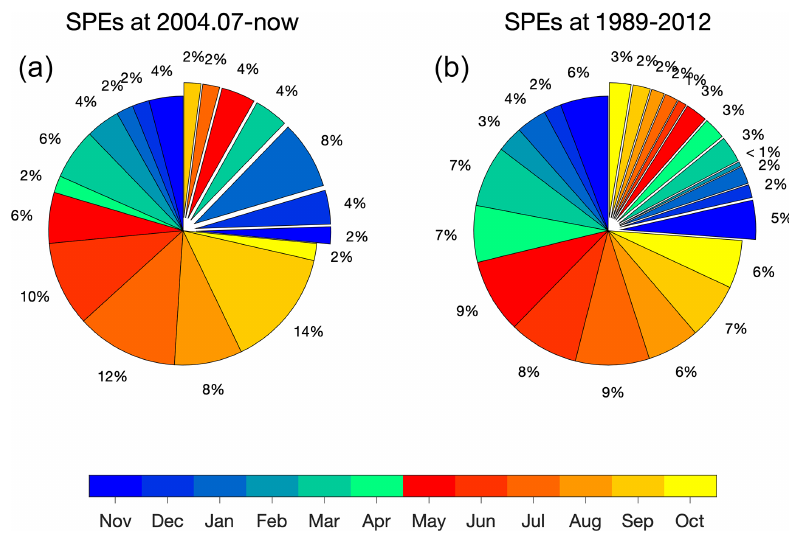
Figure A1. SPE seasonal distributions for those with fluxes > 400pfu (exploded parts of the pie charts) and the ones with fluxes < 400pfu (regular parts of the pie charts). Panel (a) demonstrates the cases in between the MLS measurement period (July 2004 to now). Panel (b) shows the cases during the WACCM-D simulation (1989–2012).